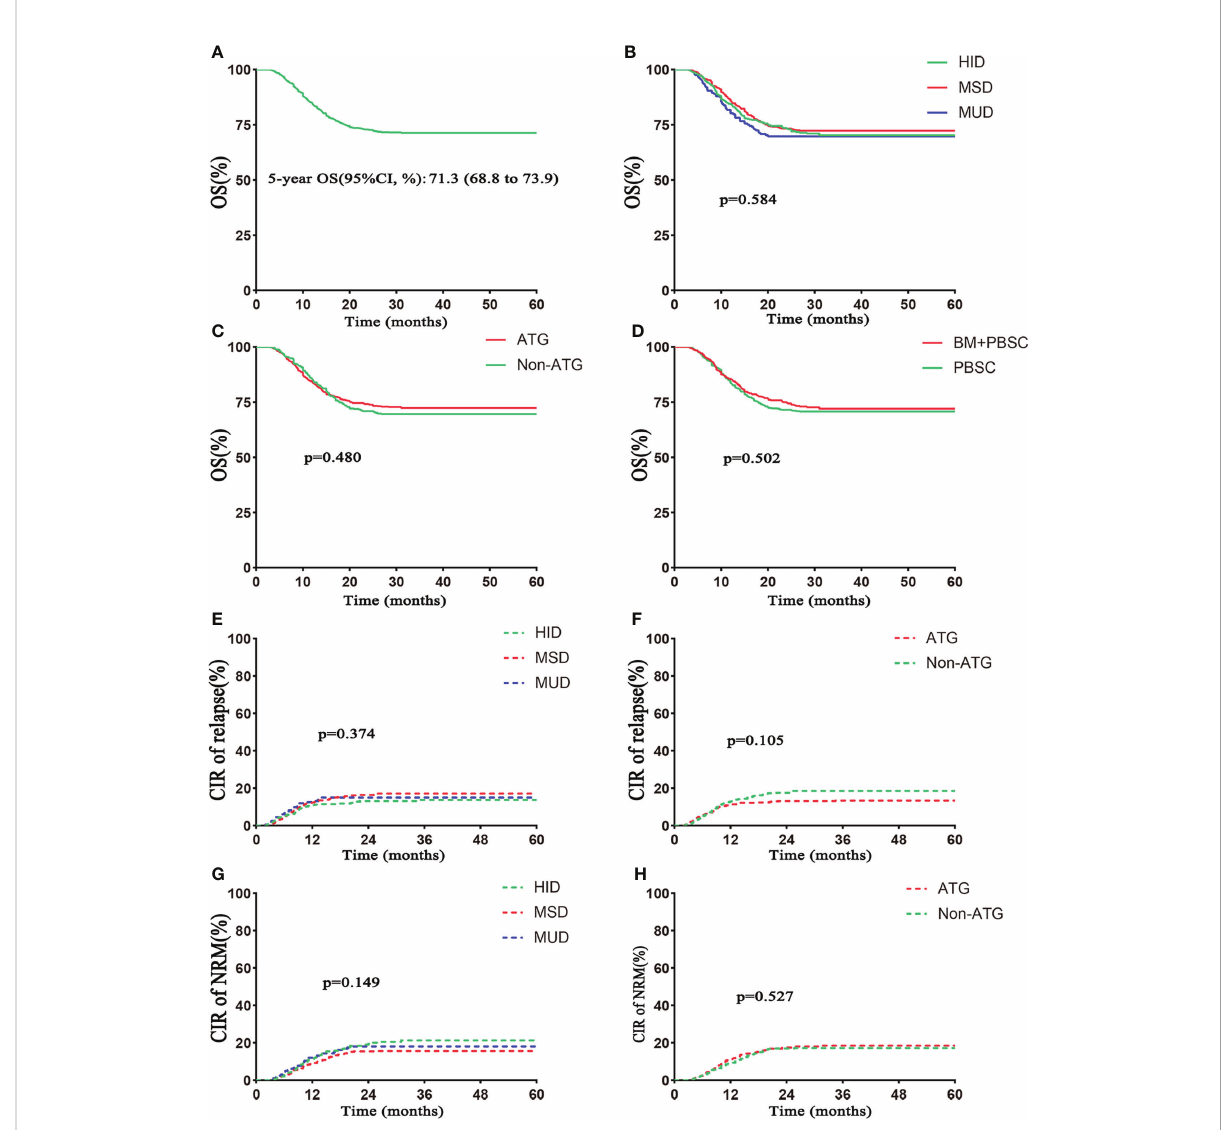
FIGURE 4 Outcomes of survival. (A) OS in the total number of patients. (B) OS based on donor type. (C) OS based on ATG. (D) OS based on grafts. The 5 – year OS rates were 72.0% (95% CI 68.0% – 76.3%) in the BM+PBSC group and 70.8% (95% CI 67.6% – 74.1%) in the PBSC group. (E) Cumulative incidence of relapse based on donor type. (F) Cumulative incidence of relapse based on ATG. (G) Non – relapse mortality (NRM) based on donor type. (H) NRM based on ATG. Follow – up started from